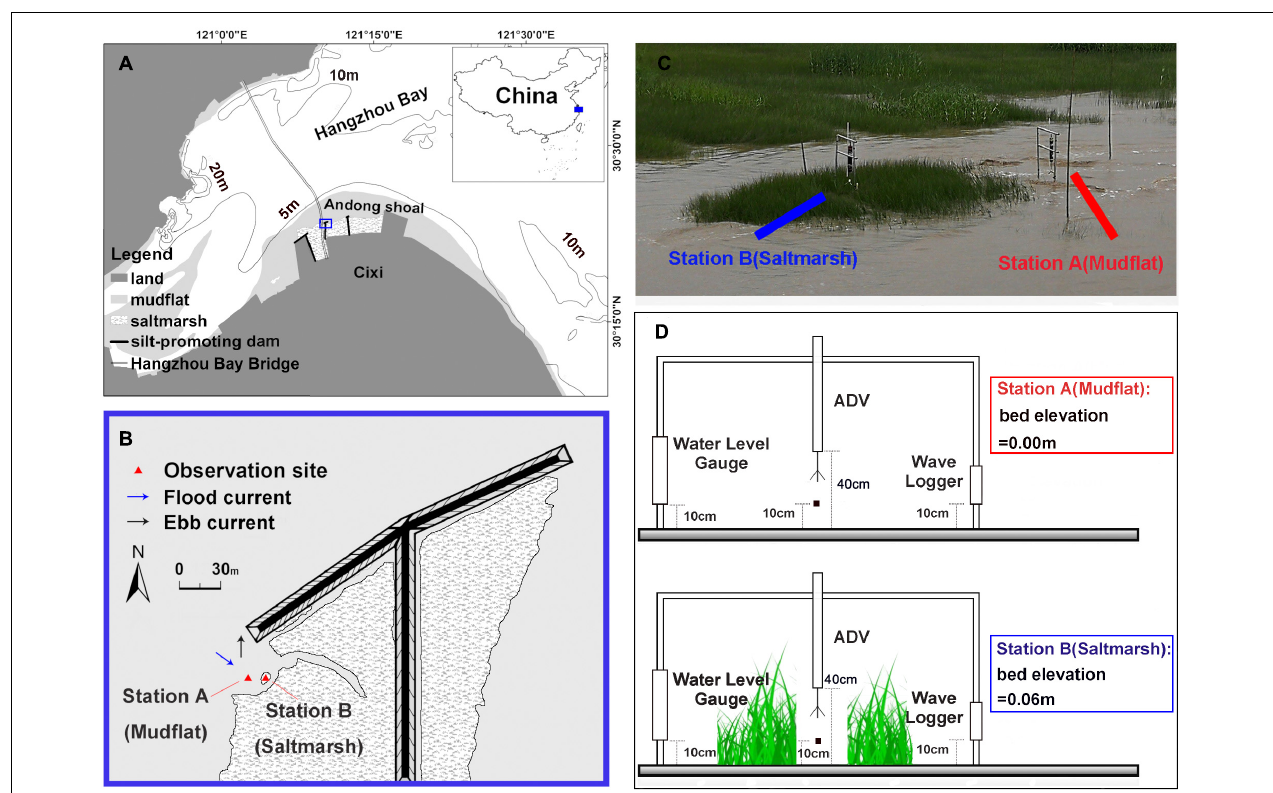
FIGURE 1 | Study area and observation sites: (A) map of Hangzhou Bay area, the study area (in the blue box) is located on the top of a T-shaped dam; (B) the deployment locations of the observation sites, Station A (mudflat) and Station B (saltmarsh). The blue arrow represents the direction of flooding, and the black arrow represents the direction of ebbing; (C) a field picture of the deployment of the observatory; (D) the position of the deployed instruments: the pressure sensor of ADV is located at 40 cm above the bed whilst the velocity sampling volume of ADV is 10 cm above the bed; water level gauge and wave logger are both 10 cm above the bed; the elevation of the bottom bed of Station B is 6 cm higher than that of Station